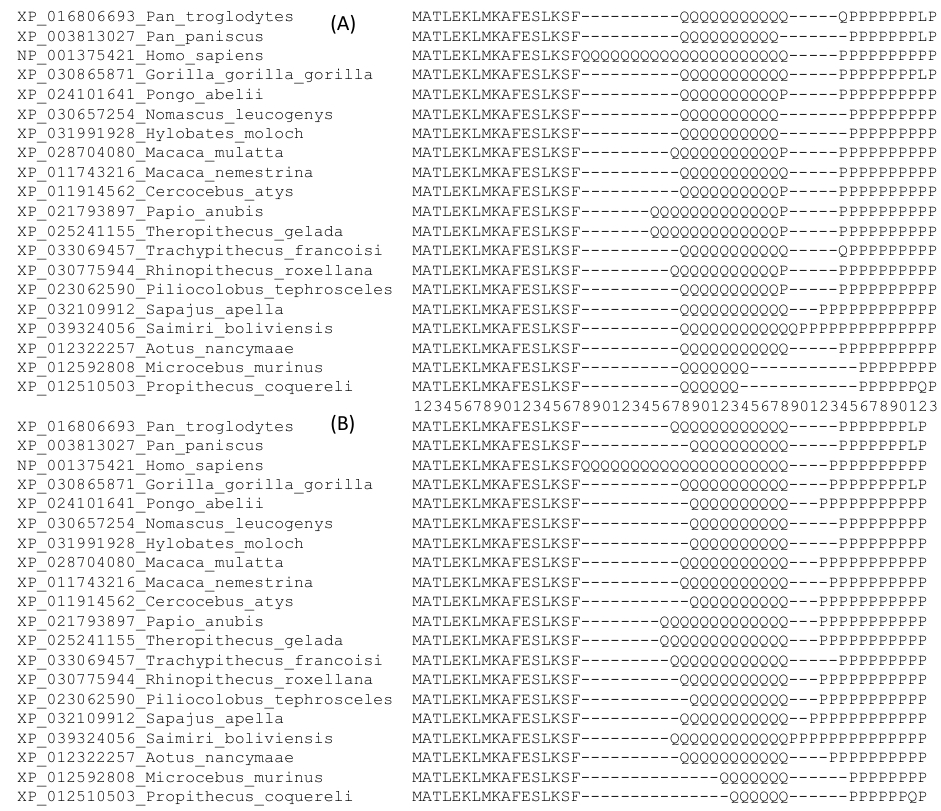
Figure 3. N-terminus of 20 aligned HTT sequences, with the site numbering in the middle. ( A ) Alignment from MAFFT [7] with optimized options. ( B ) One of the alternative alignments refined with the PWMD criterion.